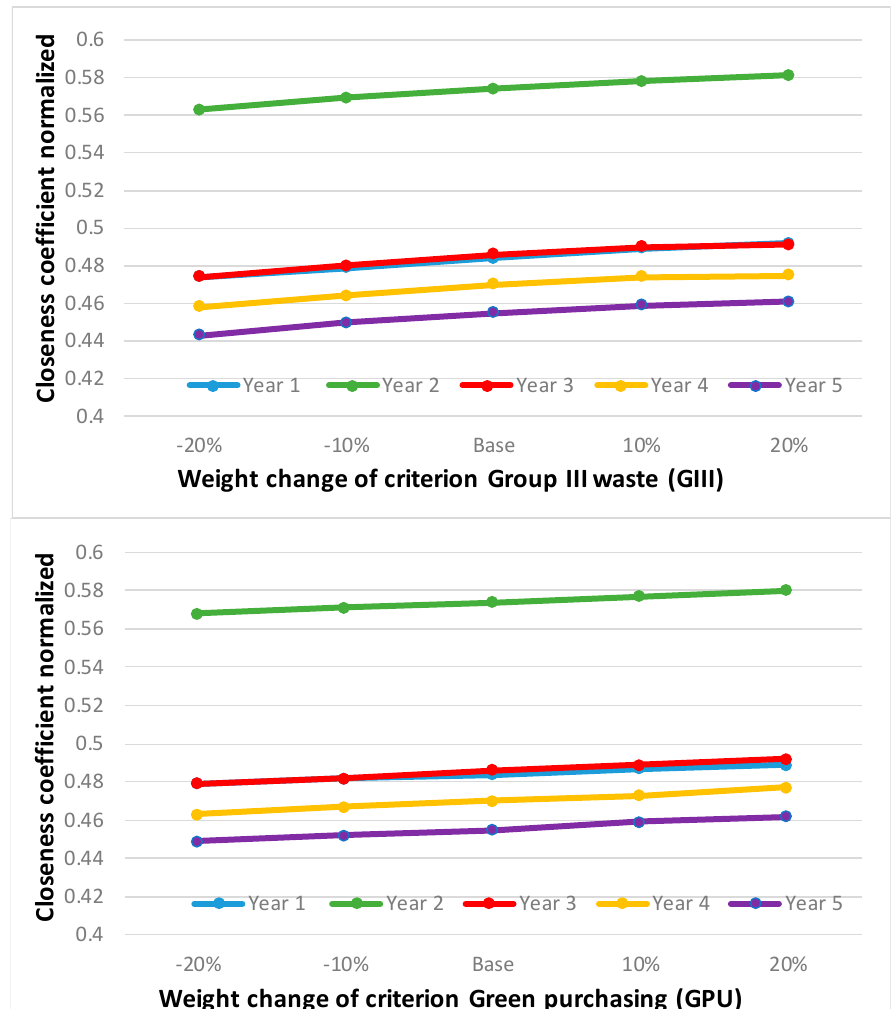
Figure A1. Sensitivity analysis results modifying the expert’s weights.